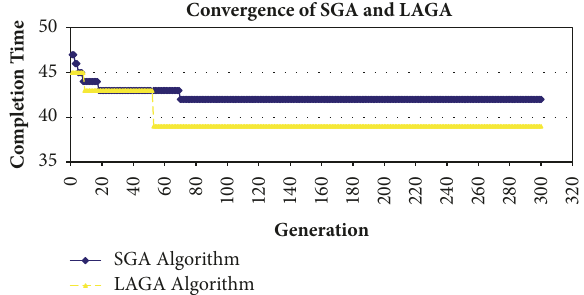
Figure 8: A Comparison of the convergence of the proposed and genetic scheduling